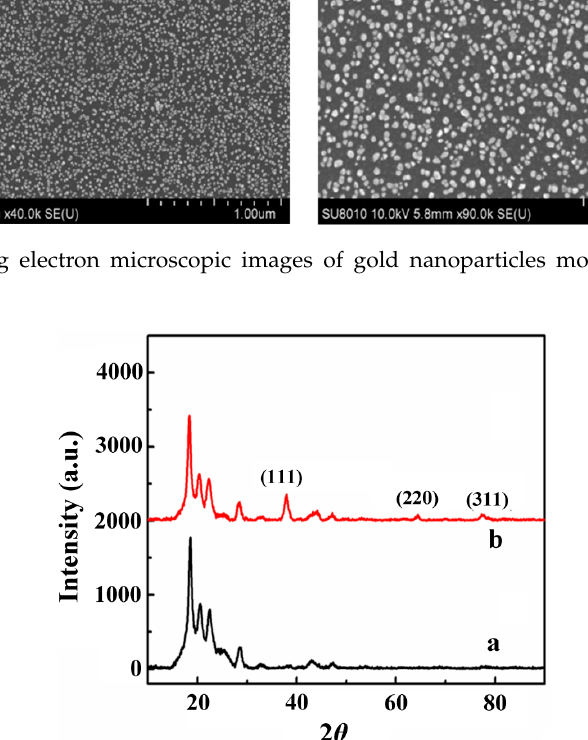
Figure 1. Scanning electron microscopic images of gold nanoparticles modified glassy carbon electrode surface.